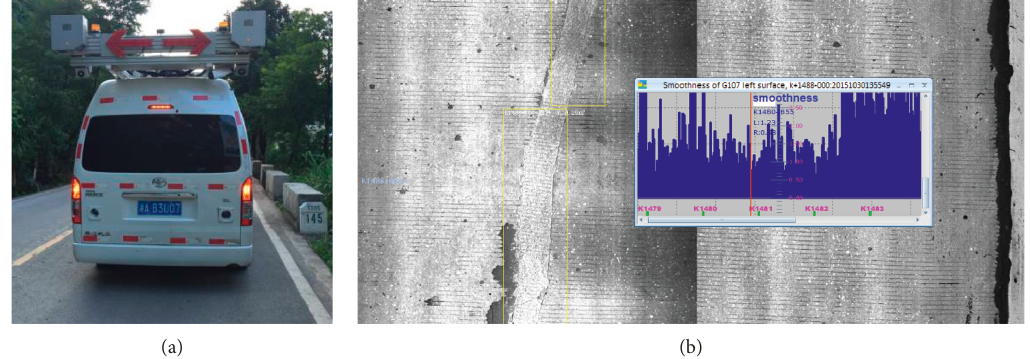
Figure 1: ZOYON-RTM intelligent road detection vehicle (a) and road image processing software